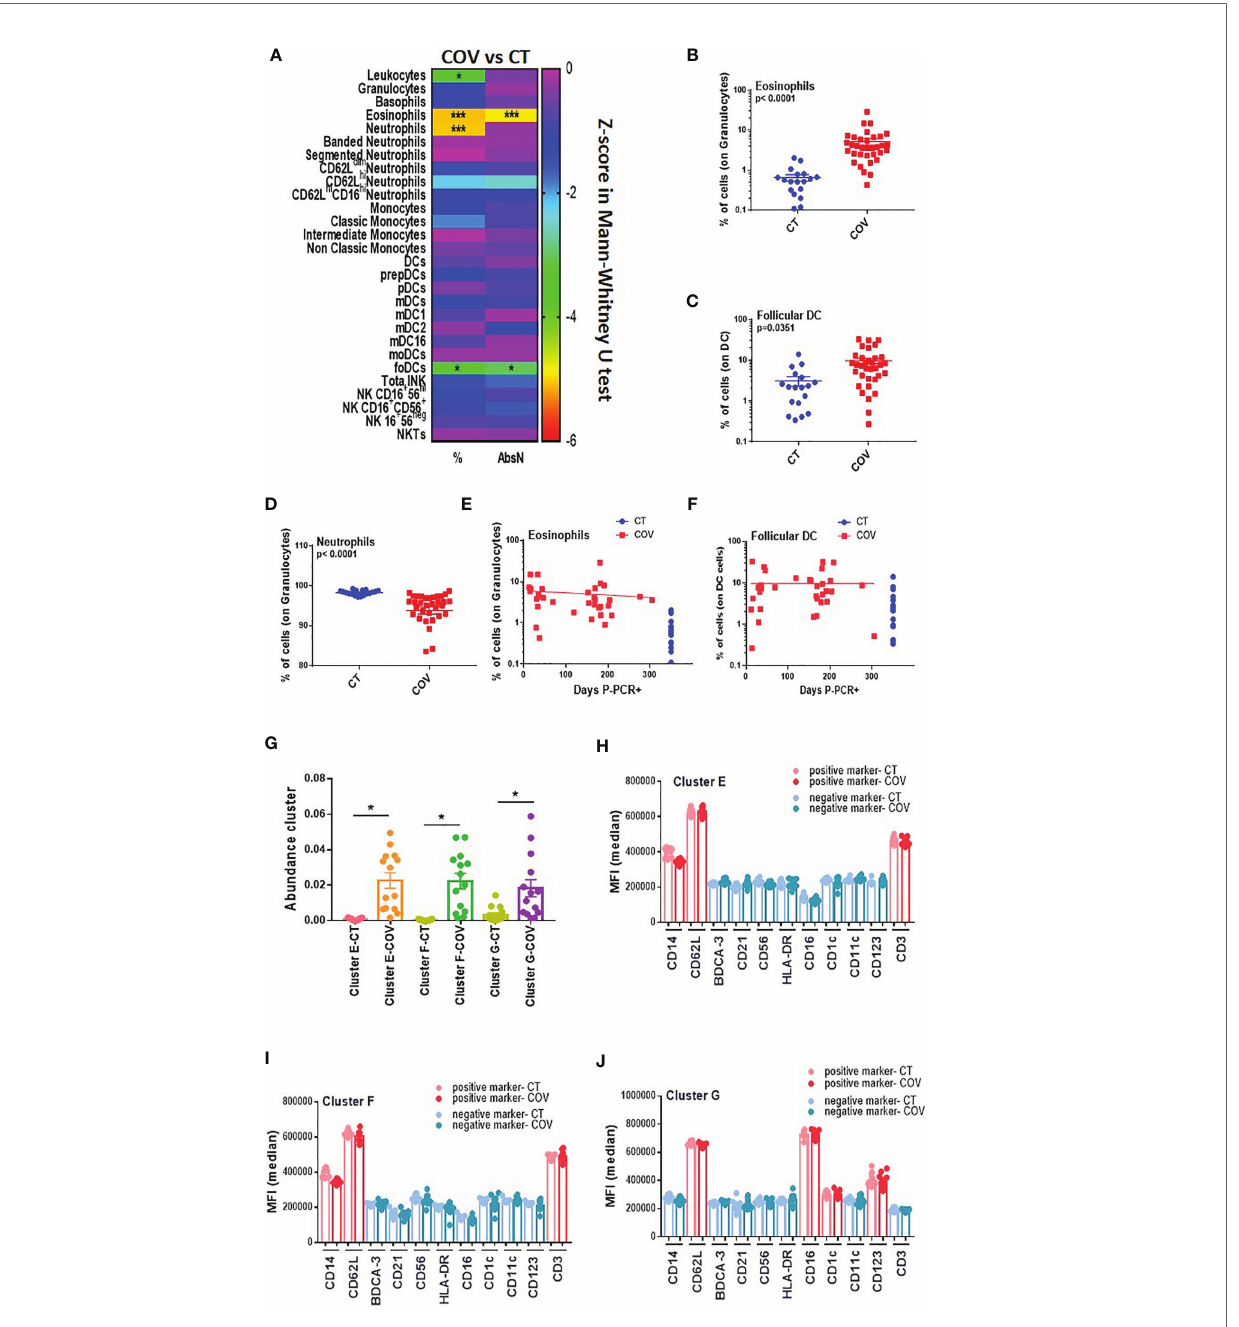
FIGURE 5 | Manual gating and high-dimensional fl ow cytometry unsupervised analysis in innate cells panel. (A) Heat map of the pairwise comparison between recovered COVID-19 (COV) and healthy control (CT) individuals of cellular subsets obtained by classical fl ow cytometry analysis. The analysis was performed with the Mann – Whitney U test. The colour scale represents the Z-score on the right Y-axis. Immune population names are represented on the left Y-axis. The left column represents the z-score from the pairwise comparison of the cellular population ’ s percentage (%), and the right column represents the z-score from the pairwise comparison of the absolute numbers (cells/uL, AbsN). The p -value was adjusted by the Benjamini – Hochberg adjustment method for multiple testing. * p < 0.05, and *** p < 0.001. (B) Frequency of eosinophils and (C) follicular DC in CT and COV individuals. Pairwise comparisons were performed by Mann – Whitney U-test with Benjamini – Hochberg adjustment for multiple testing. Mean ± SEM. (D) Frequency of neutrophils in CT and COV individuals. Pairwise comparisons were performed using Mann – Whitney U-test with Benjamini – Hochberg adjustment for multiple testing. Mean ± SEM. (E) Correlation between days P-PCR+ and frequency of eosinophils or (F) follicular DC. Spearman ’ s rank-order correlation test with Benjamini – Hochberg adjustment for multiple testing. (G) The abundance of clusters was signi fi cantly different between CT and COV individuals and was obtained through CITRUS analysis. One-way ANOVA with Benjamini – Hochberg adjustment for multiple testing. Median ± SEM. (H) MFI of cluster E, (I) cluster F, and (J) cluster G were obtained through CITRUS analysis. One-way ANOVA with Benjamini – Hochberg adjustment for multiple testing. Median ± SEM. * p <